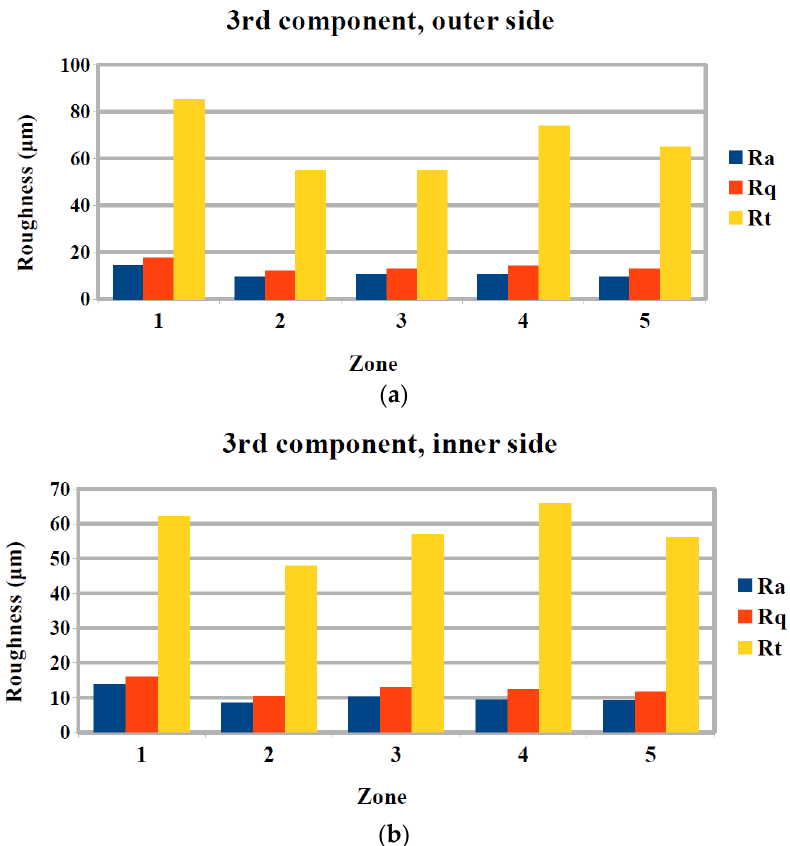
Figure 12. Surface roughness measurement results for the third femoral component for ( a ) outer and ( b ) inner side.